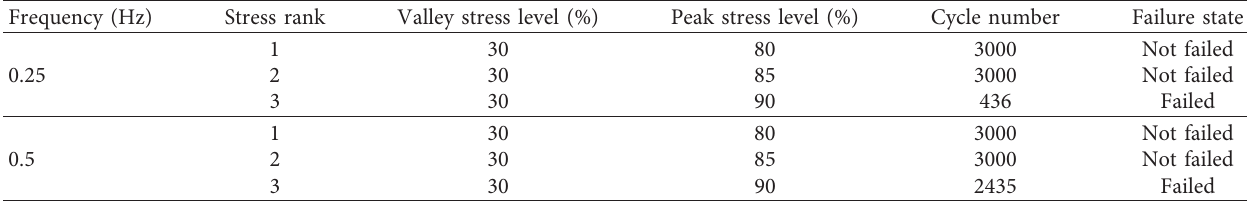
Table 1: Test schemes and results of representative specimens subjected to cyclic loading under uniaxial stress state. Frequency (Hz)